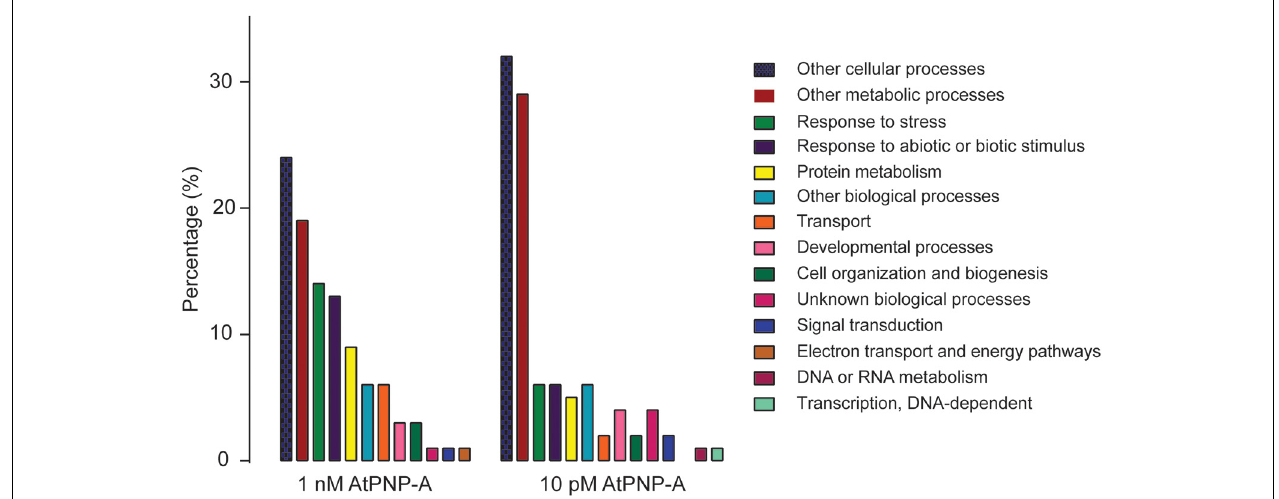
FIGURE 3 | Comparison of GO categories differentially regulated by AtPNP-A at 1nM and 10pM concentration.